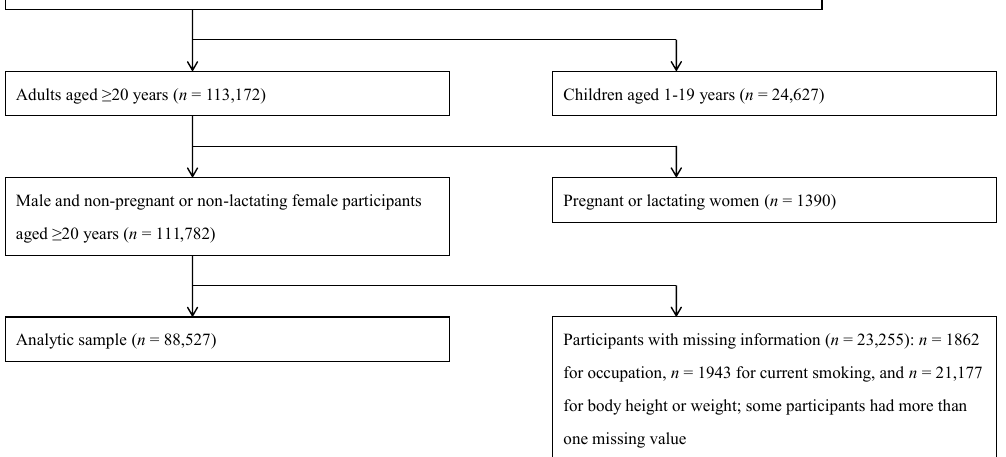
Figure 1. Flow diagram of the study participants.